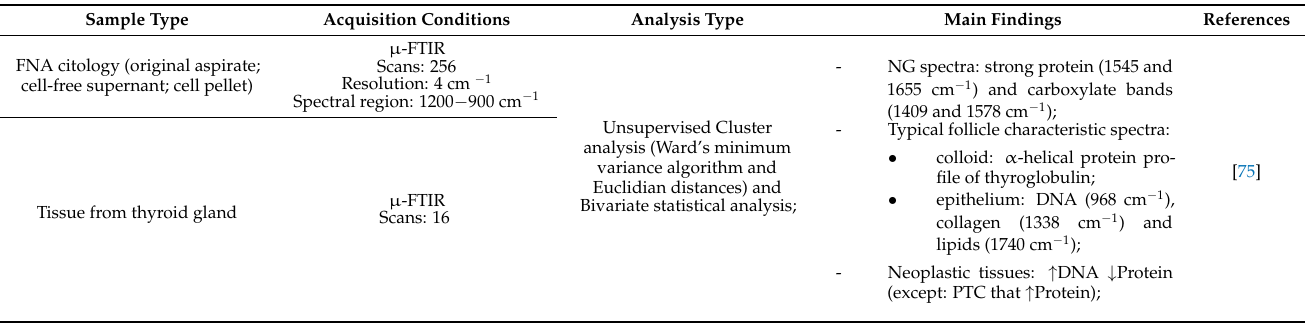
Table 1. Summary of the FTIR spectroscopy research studies in the characterization of normal and cancerous thyroid samples, highlighting the sample and analysis types, acquisition parameters and the principal findings of each study. Search for studies performed on 22 December 2021, on PubMed, under the following terms: (“Thyroid Gland”[MAJR]) AND (“Spectroscopy, Fourier Transform Infrared”[MeSH]); and on ScienceDirect, under the following terms: (Infrared Spectroscopy AND Thyroid tumor AND FNA cytology). The results were manually filtered to ensure that they all reported studies that use FTIR spectroscopy in the analysis of normal and nodular thyroid samples. Articles in Chinese and academic research documents were excluded from the table. The sequence of the articles in the table follows a chronological order. ( ↑ increase; ↓